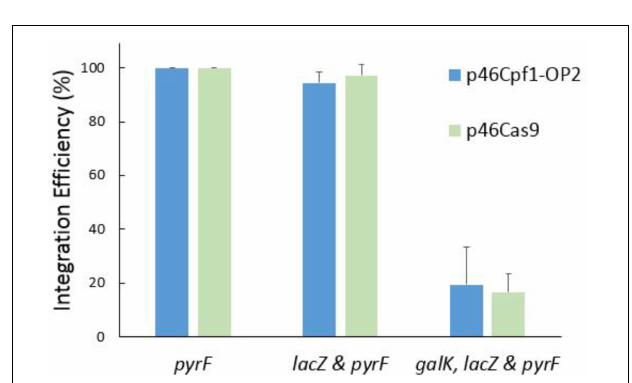
FIGURE 6 | Recombination efficiency of different CRISPR systems. The helper plasmid p46Cpf1-OP2 was combined with the donor plasmids pTc-P, pTc-PL, and pTc-GLP to perform simultaneous modifications at a single locus ( pyrF ), two loci ( lacZ and pyrF ) and three loci ( galK , lacZ, and pyrF ), respectively. For recombination based on CRISPR-Cas9, p46Cas9, pTs-P, pTs-PL, and pTs-GLP were used. The data represent the averages of three independent